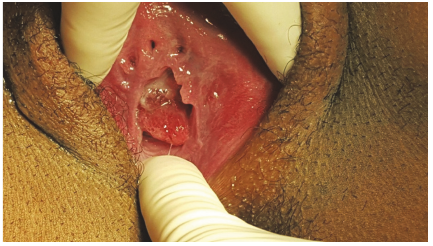
Figure 1: Cervical prolapse reaching the level of the introitus.